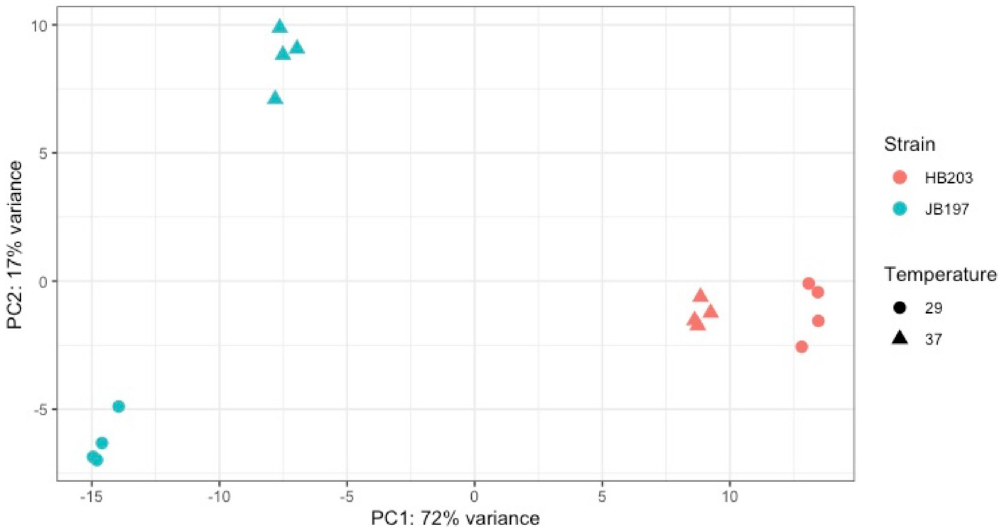
Fig 2. Principle Component Analysis (PCA) of strain and